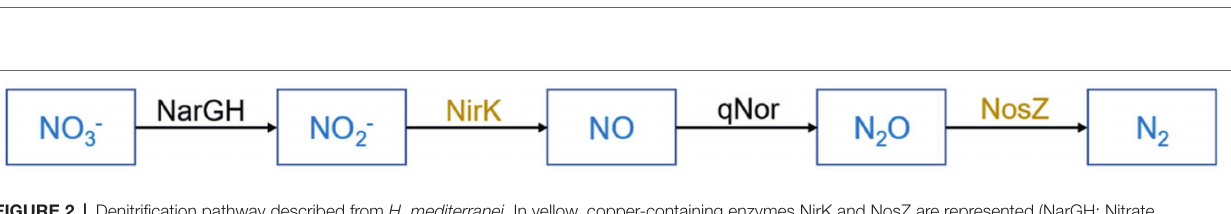
FIGURE 1 | Overview on H. mediterranei copper uptake and efflux transporters that might be involved in copper transport. (IM: Inner membrane). Considering that some genes involved in siderophores synthesis have been identified, potential siderophores are also presented as they contribute to facilitating the uptake of metals. CopG is also represented as the converter of copper (I; black dot) into copper (II; grey dot) and vice